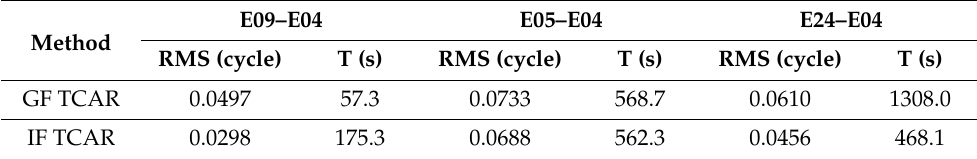
Figure 4. The optimal WL ambiguity residual by GF TCAR method (upper row) and IF TCAR method (lower row), as well as the satellite elevation angle by two TCAR methods. GF TCAR: geometry-free three-carrier ambiguity resolution; IF: ionospheric-free; ( a , d ) are the GF and IF of E09–E04; ( b , e ) are the GF and IF of E05–E04; ( c , f ) are the GF and IF of E24–E04. Table 2. The mean RMS of the Galileo WL ambiguity residuals and the convergence time.